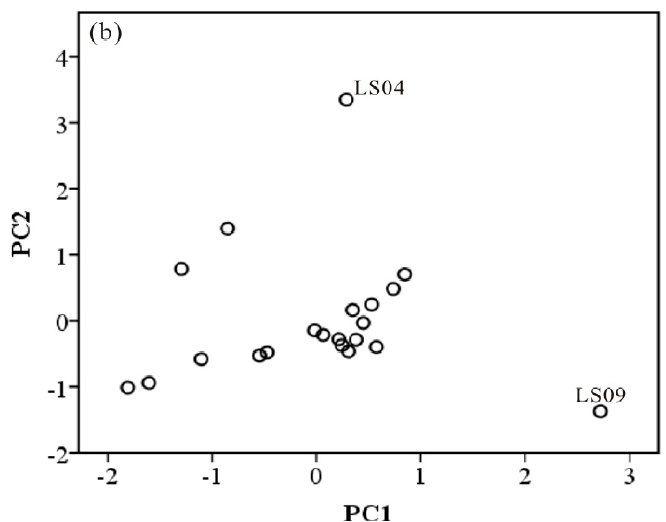
Figure 5. The principal component analysis results heavy metals. ( a ) Factor loadings; ( b ) factor scores. Int. J. Environ. Res. Public Health 2019 , 16 , 336